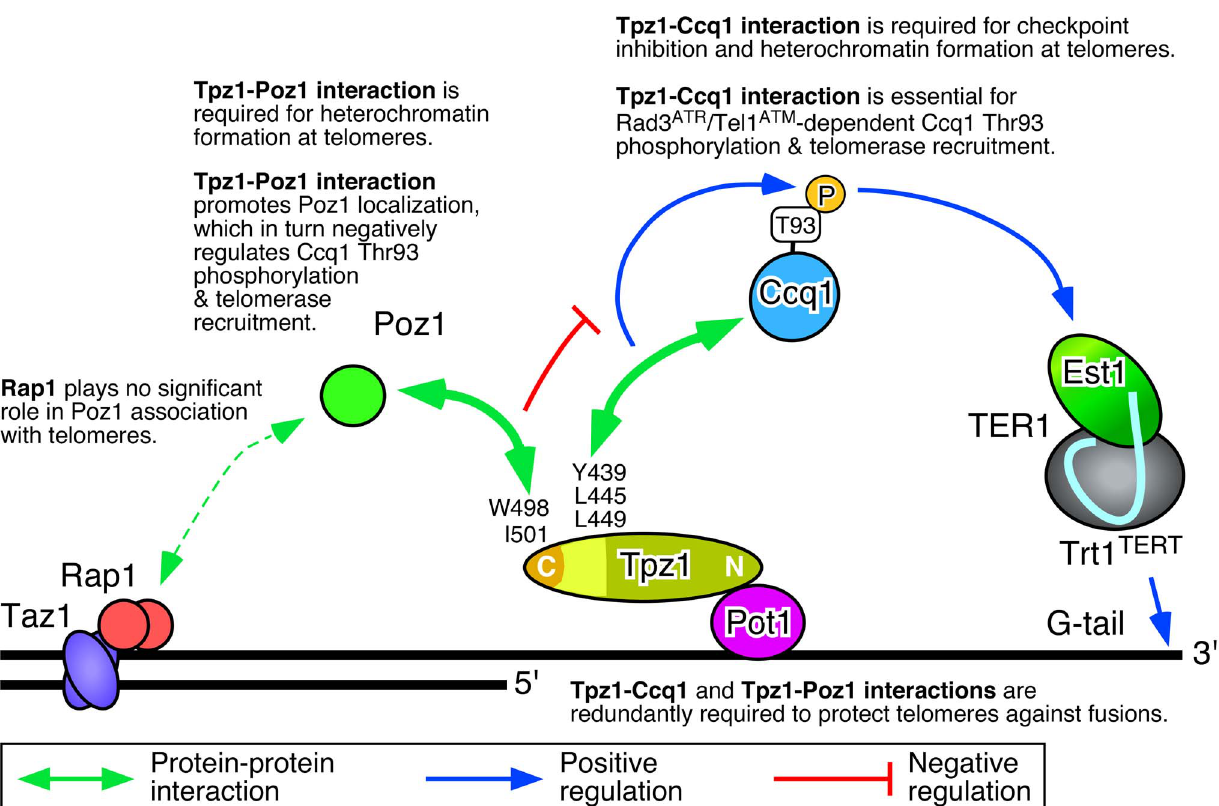
Figure 8. Summary of key findings from the current study. Our current study establish that (1) Tpz1-Ccq1 interaction is essential for Ccq1 Thr93 phosphorylation and telomerase recruitment, (2) Tpz1-Poz1 interaction promotes efficient accumulation of Poz1 to inhibit Ccq1 Thr93 phosphorylation and telomerase recruitment, and (3) Tpz1-Ccq1 and Tpz1-Poz1 interactions are redundantly required for protection against telomere